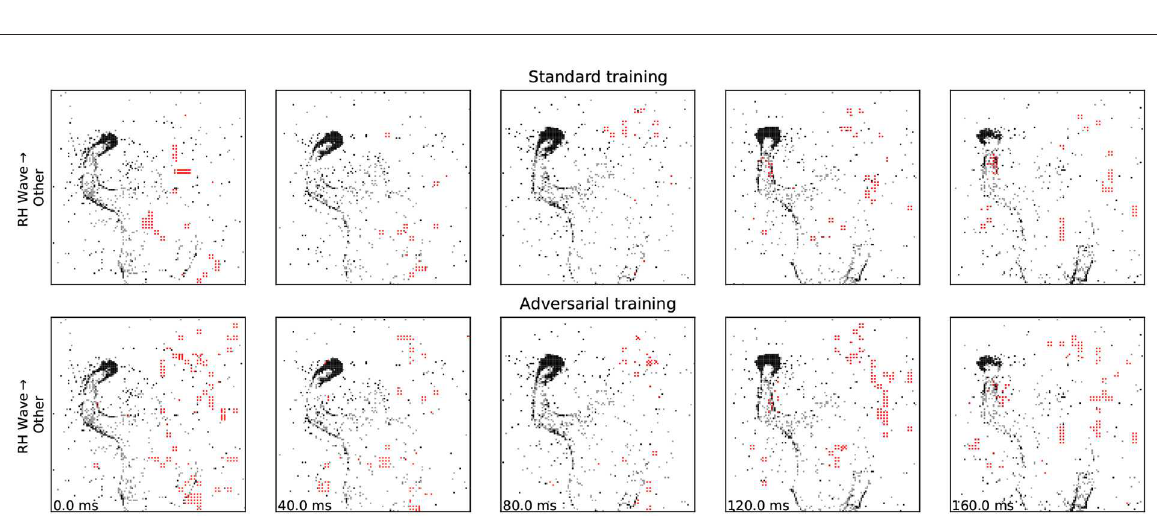
FIGURE5 Adversarial training visibly increases the number of events that need to be added/removed in order to trigger a